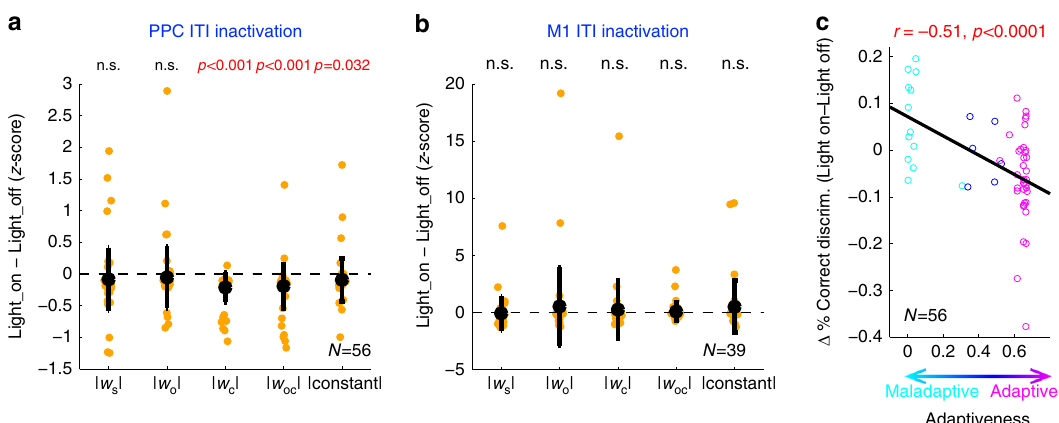
Fig. 8 Inactivating pre-stimulus activity in PPC weakens the history dependency of choice. a Changes in the magnitude of model weights by PPC ITI inactivation. The weight magnitude of light-on model was translated into a z -score relative to the distribution of weight magnitudes of light-off models in each session. The weight magnitude for choice history, outcome-choice interaction history, and constant signi fi cantly decreased by PPC ITI inactivation (bootstrap, p < 0.001, p < 0.001, and p < 0.05 respectively). Black, mean ± s.d. across sessions. b The same as a , but for M1 ITI inactivation. c Change in behavioral performance during ITI inactivation (light-on – light-off) as a function of the degree of adaptiveness of the strategies (cyan: maladaptive, blue: neutral, and magenta: adaptive strategy sessions, respectively). The negative correlation between the performance change and the degree of adaptiveness indicates that ITI perturbation improves performance in sessions with maladaptive strategies, whereas it deteriorates performance in sessions with adaptive strategies. Black, linear